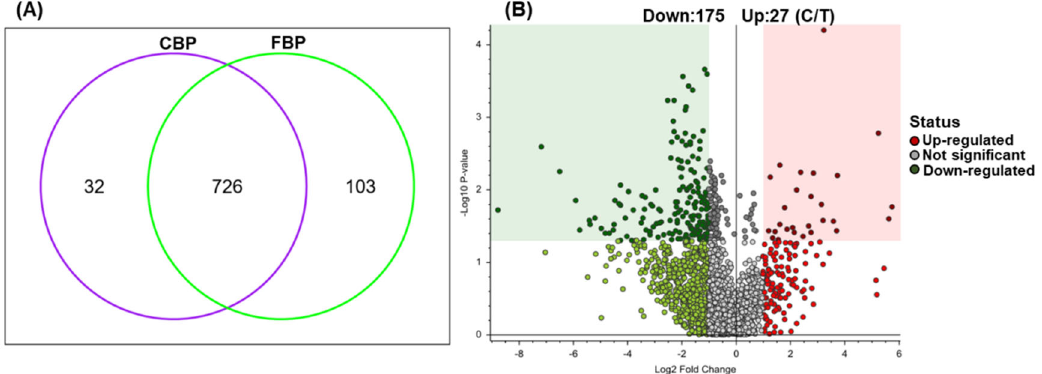
Figure 5. Metabolite contents of the raw B. papyrifera (CBP) and the Lp − fermented B. papyrifera product (FBP) under practical condition. ( A ) Venn diagram and ( B ) volcano plots (CBP vs. FBP). Table 1. Characterization of the raw (CBP) and the Lp ‐ fermented B. papyrifera product (FBP) under practical condition.